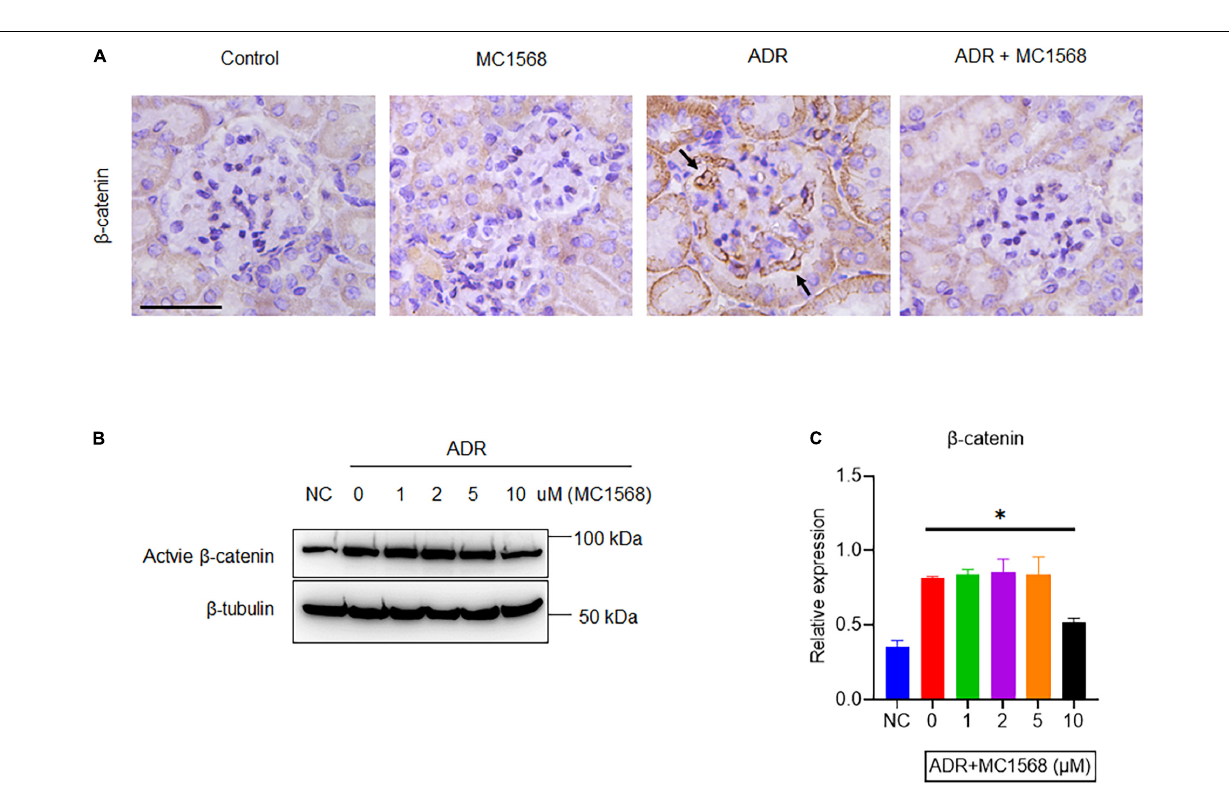
Frontiers in Medicine |